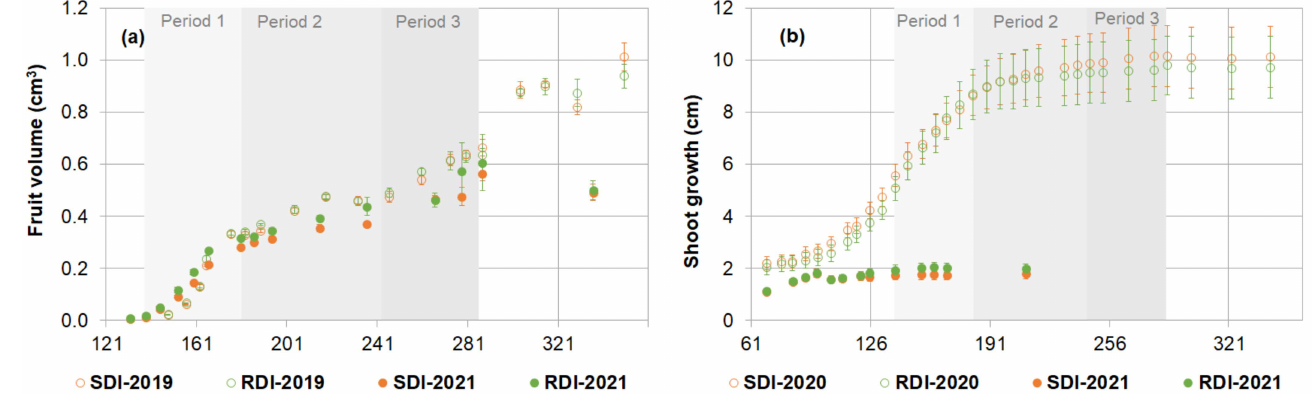
Figure 2. Average fruit volume in 2019 and 2021 ( a ) and shoot length in 2020 and 2021 ( b ) for five replicate plots for sustained (SDI) and regulated (RDI) deficit irrigation treatments. Periods 1–3 are indicated with grey colouring. Error bars are standard